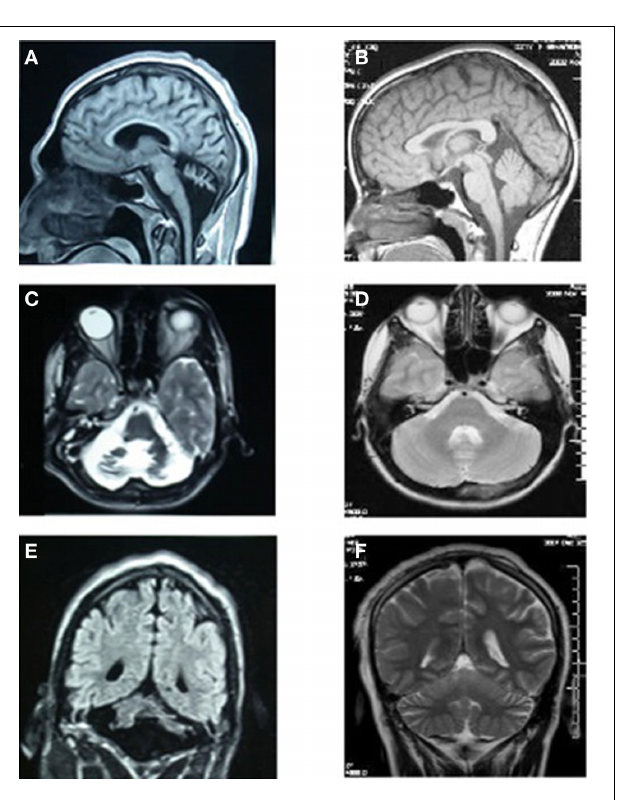
construct only simple sentences, without using “and,” and